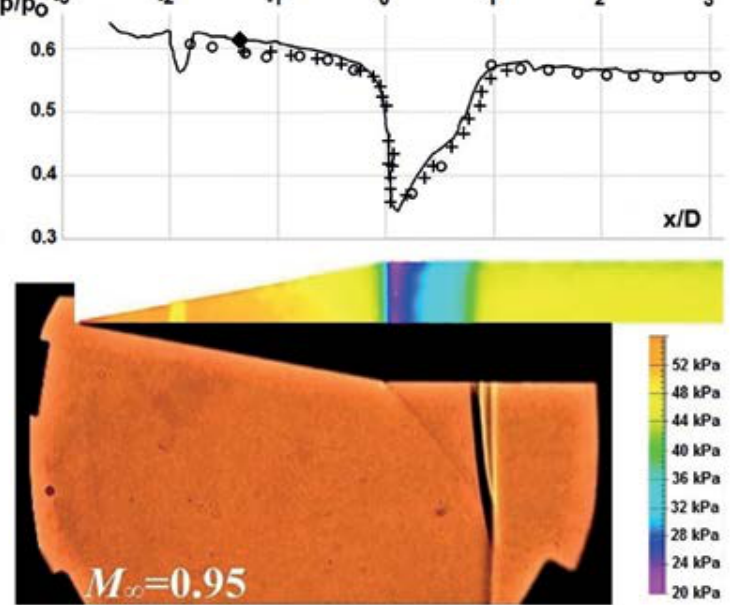
Figure 14. Comparison of results from PSP technique and Schlieren image for cone–cylinder model with a blockage area ratio of 0.78% for a stagnation pressure of 80 kPa and a stagnation temperature about 300 K. Conventions in the graphic are: solid line = PSP result; black diamond = pressure tap result; cross = experimental results from AEDC 16T (0.008% of BR); hollow circle = experimental results from MSFC 14 in (1.47% of